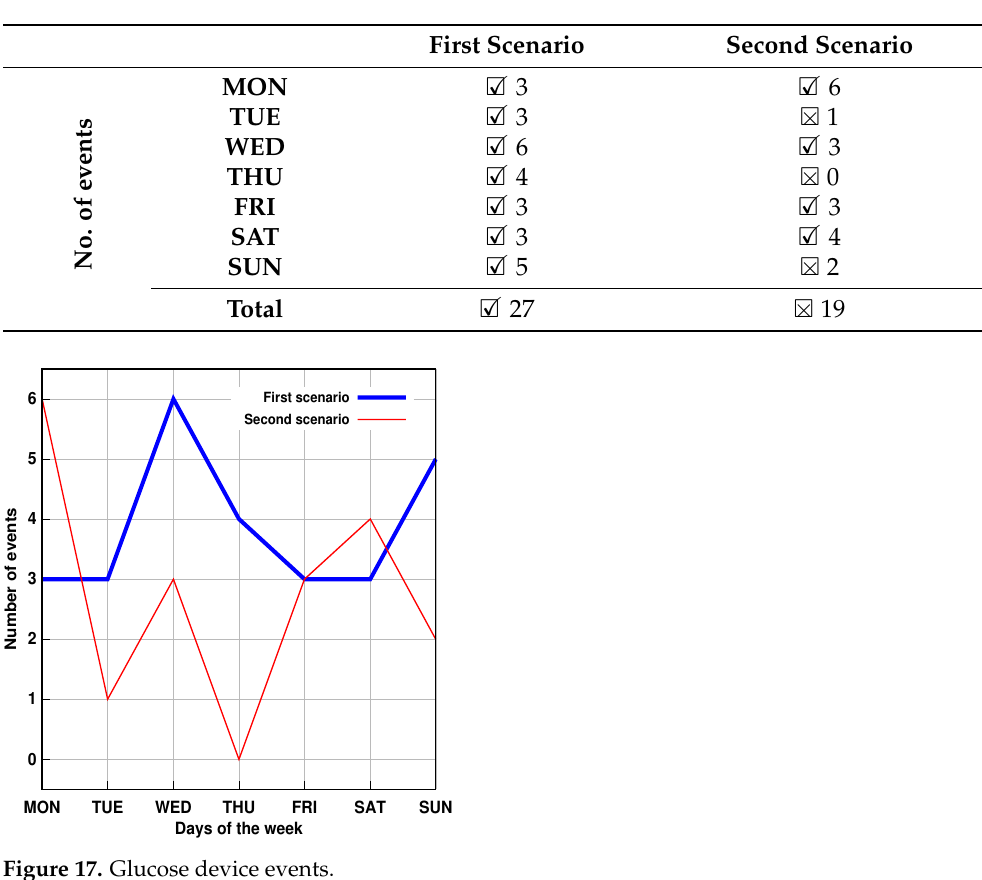
Table 21. Results of the first scenario.